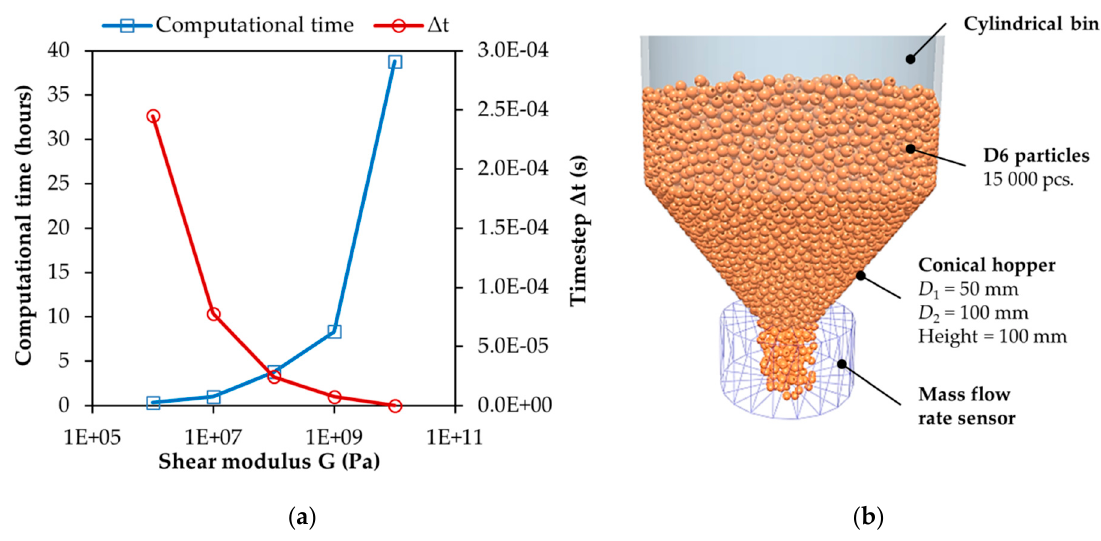
Figure 6. ( a ) Computational time and timestep versus shear modulus; ( b ) experimental setup.